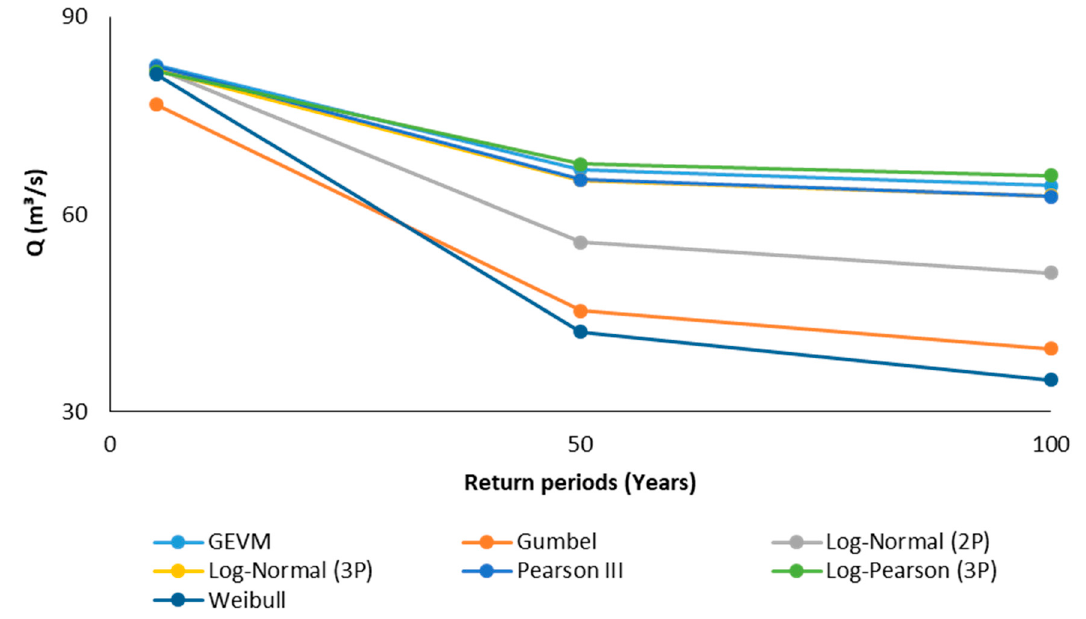
Figure 3. Adjustment of distributions for minimum flows in return periods of 5, 50, and 100